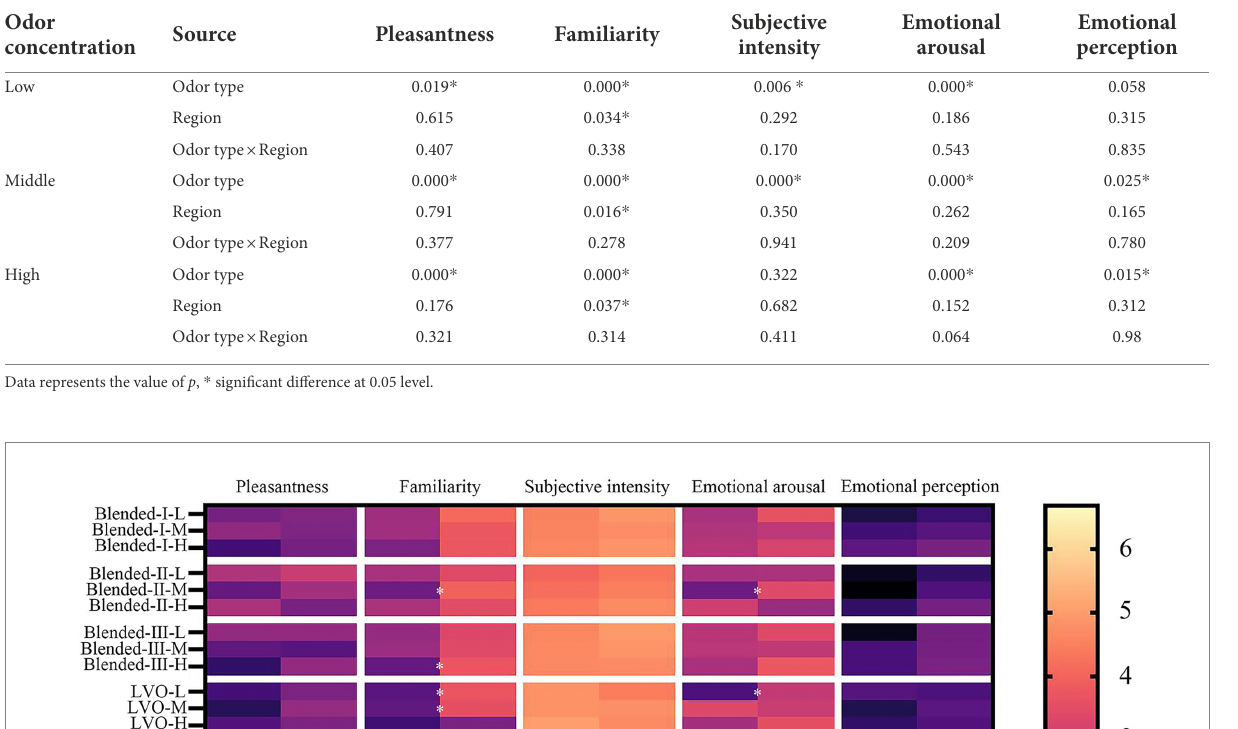
TABLE 8 The significance of the indicators under main effect and interaction of region and type.